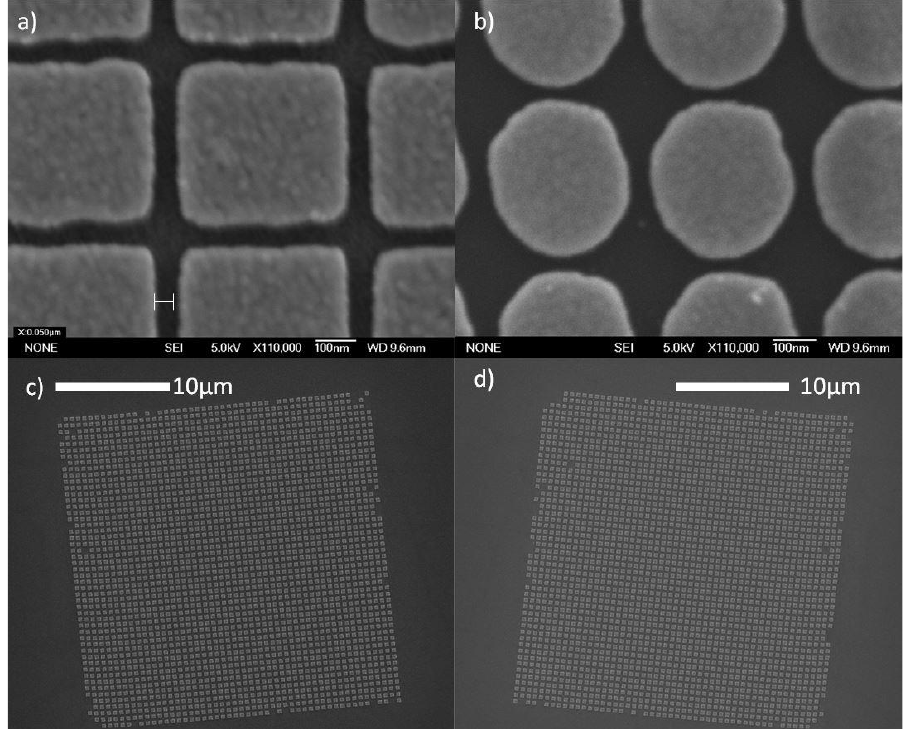
Figure 4. ( a ) SEM images of a 2D gold grating on a sacrificial layer of Cr with proximity effect correction; ( b ) SEM images of a 2D gold grating on Cr without proximity effect correction; ( c ) SEM image of a 2D gold grating with edge length of 200 nm and period of 500 nm before structural transfer; ( d ) SEM image of the grating structure transferred to PDMS substrate in ( c ). Dark-field characterization was performed using a Zeiss Axio Scope A1 reflectance setup. The incident light was unpolarized and produced by a 100 W halogen lamp focused through a dark-field spot lens with a numerical aperture of 0.95 to 0.99. A 100× objective with a numerical aperture of 0.9 was chosen to collect the scattered light. The collected light was analyzed using a grating spectrometer (LOT SR -303i-B). The grating had a linear density of 150 L/mm and a central wavelength of 700 nm. The detector used was a camera (Andor iDus CCD) with a pixel size of 15 × 15 μm 2 and a 2000 × 256-pixel chip was used as a detector. The slit width was 100 μm, so a rectangle of 1 × 1.05 μm 2 was used for spec- tral analysis. The two opposite sides of the flexible substrate were fixed to the stretching device; see Figure 4a,b. The initial length between the two fixtures was set to 10 mm, and each stretching length was 1 mm. The exposure time was 3 s, and the measurements were repeated five times for averaging. The spectra of the structures to be measured, the struc- tureless substrate, the light source and the dark current were measured separately and calculated using Equation (5). The result obtained was the corrected scattering spectrum. 𝑆𝑐𝑎𝑡𝑡𝑒𝑟𝑖𝑛𝑔 = 𝐼 𝑠𝑡𝑟 − 𝐼 𝑏𝑎𝑐𝑘𝑔𝑟𝑜𝑢𝑛𝑑 𝐼 𝑙𝑎𝑚𝑝 − 𝐼 𝑑𝑎𝑟𝑘 (5) where 𝐼 𝑠𝑡𝑟 is the light intensity scattered by the nanostructure, 𝐼 𝑏𝑎𝑐𝑘𝑔𝑟𝑜𝑢𝑛𝑑 is the light in- tensity scattered by the substrate. 𝐼 𝑙𝑎𝑚𝑝 denotes the incident light intensity and 𝐼 𝑑𝑎𝑟𝑘 rep- resents the scattered light intensity due to the dark-field current. 3. Results A 2D flexible grating with more precise structures was produced by calculations to correct the proximity effect. As shown in Figure 4. Figure 4a,b are SEM images of the fab- ricated gold 2D grating structures with and without proximity effect correction, respec- tively. The structures in both figures are square and have a side length of 300 nm. It can be seen that the structures exposed with proximity effect correction have clearer